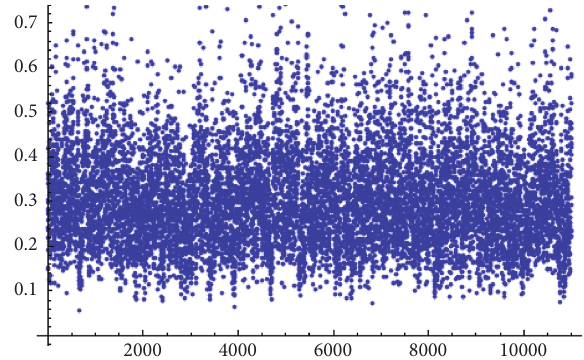
Figure 3: Simulation number of θ